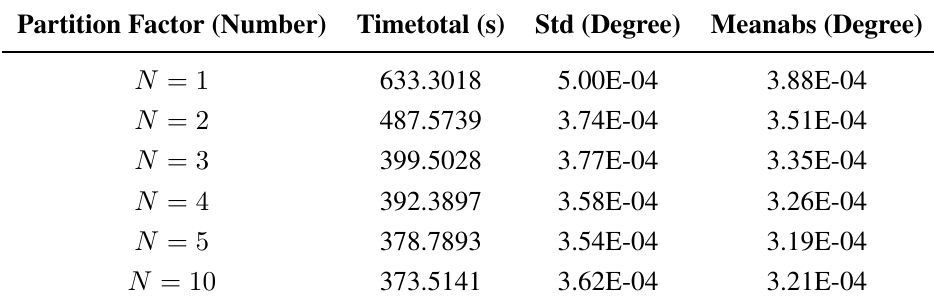
Table 4. Decomposition algorithm evaluation of compensating for certain trend